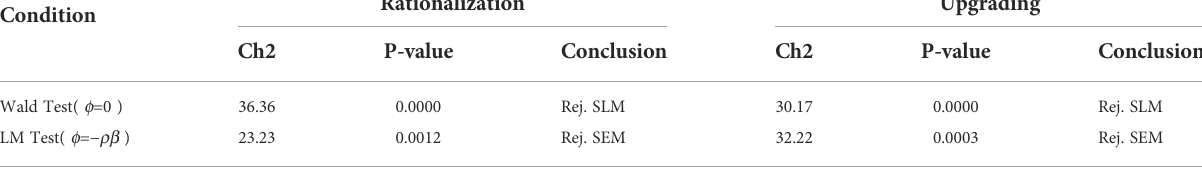
TABLE 4 Model test results and conclusions.